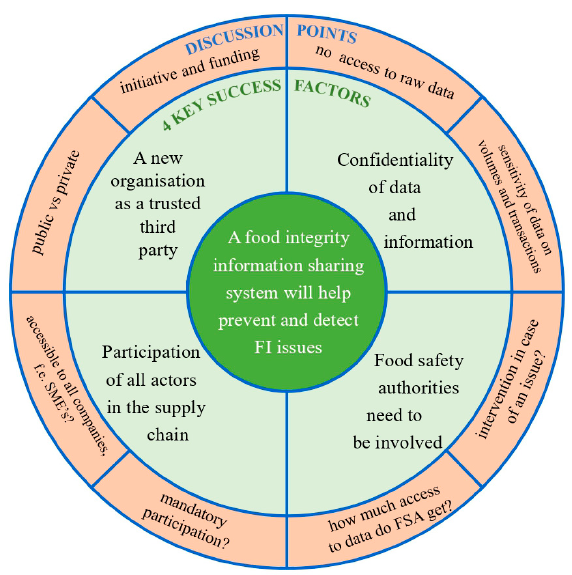
Figure 4. Four key success factors and associated discussion points for a food integrity information sharing system (FI-ISS). SME, small and medium-sized enterprise; FSA, food safety authorities.